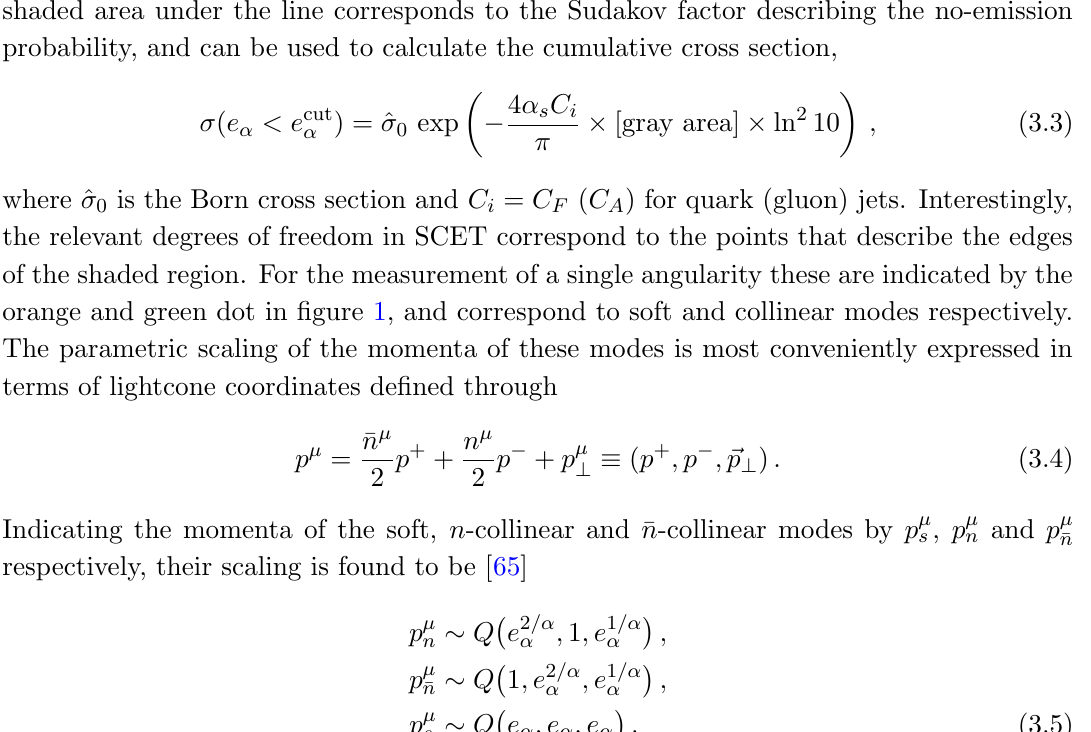
Figure 1 . Illustration of the Lund plane with x = log represent emissions and the red line the measurement of an angularity ‘ (cid:11) , set by the dominant emission. There can be no emissions in the shaded area, while emissions above this only contribute at higher order. The green and orange dot denote the collinear and soft mode